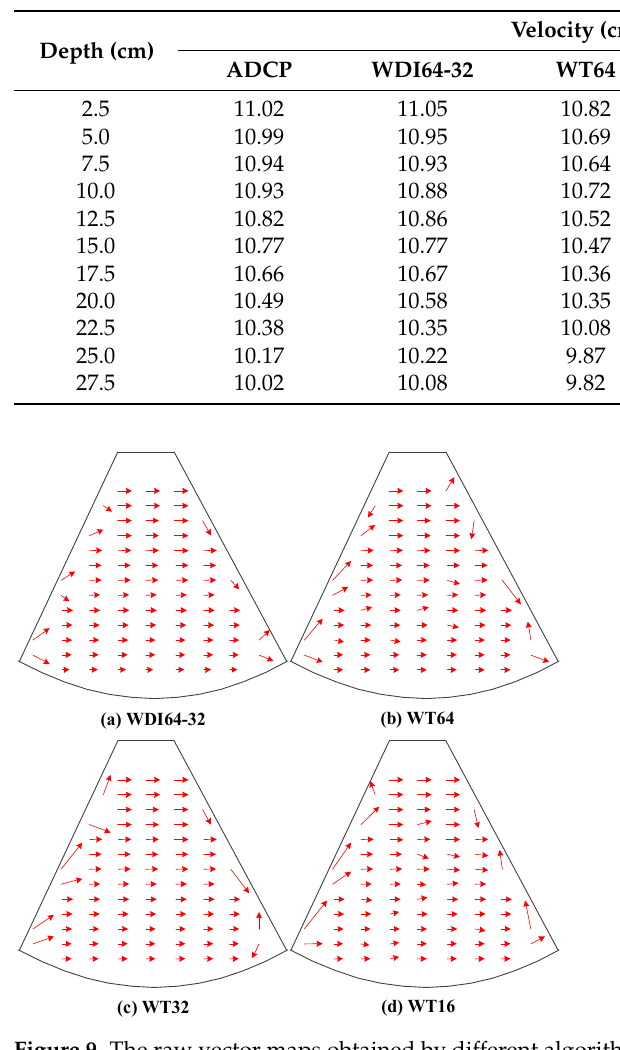
Figure 9. The raw vector maps obtained by different algorithms: ( a ) is the vector map obtained by the iterative multi-grid deformation technique with the size window interrogation from 64 × 64 to 32 × 32, referred to as WDI64-32; ( b ) is the vector map obtained by cross-correlation with the size of window templates 64 × 64, referred to as WT64; ( c ) is the vector map obtained by cross-correlation with the size of window templates 32 × 32, referred to as WT32; ( d ) is the vector map obtained by cross-correlation with the size of window templates 16 × 16, referred to as